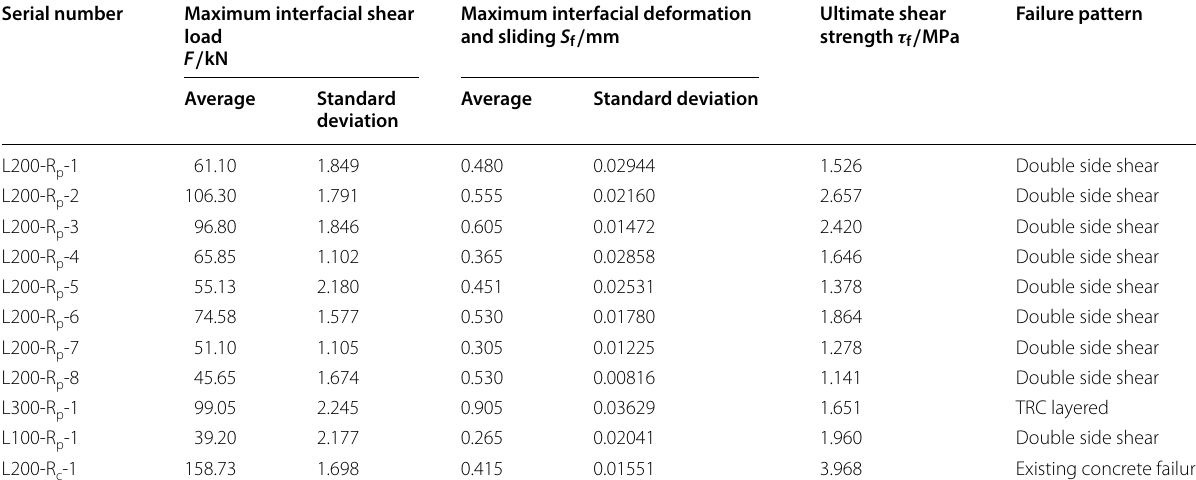
Table 5 Specimen bond properties and failure forms.